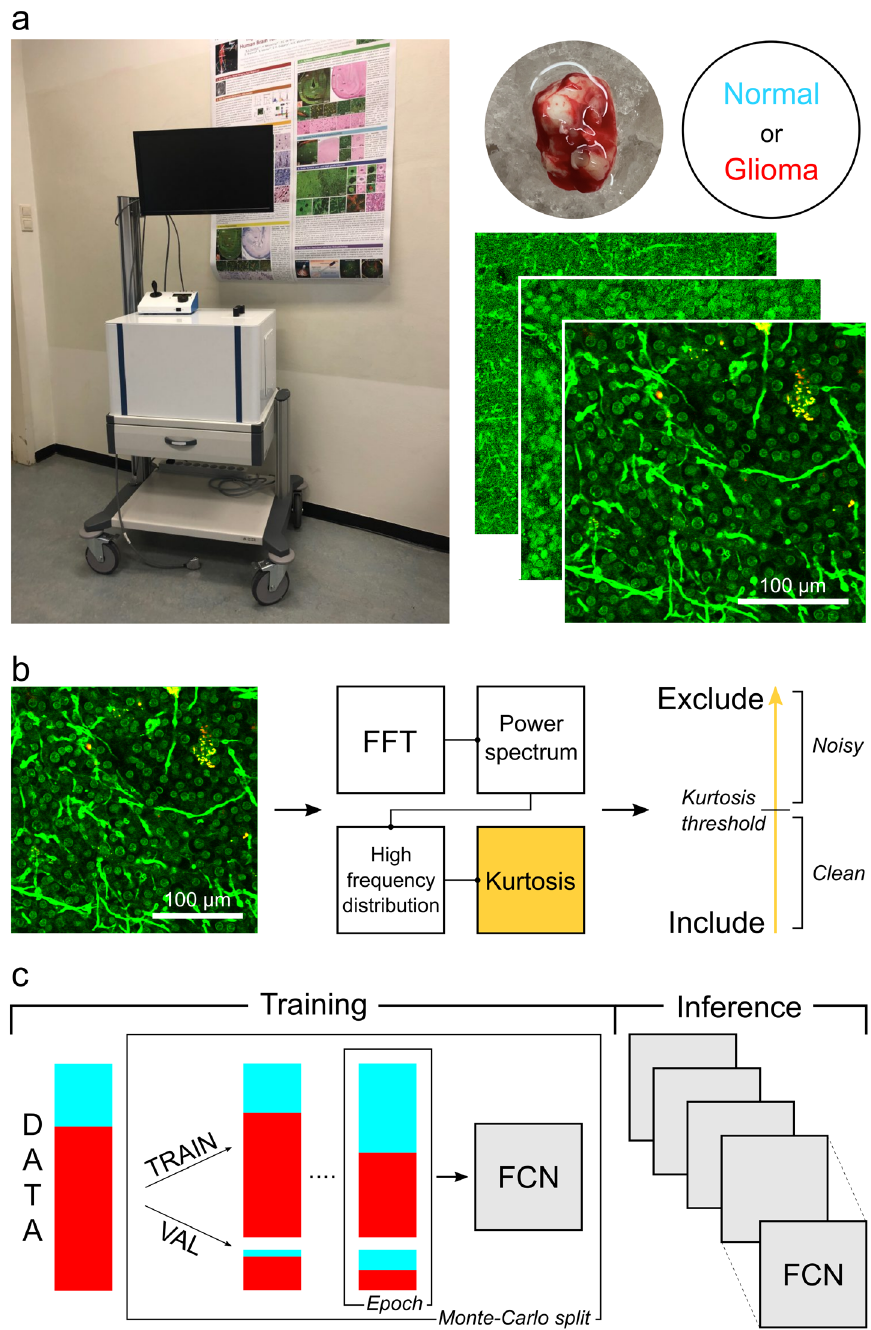
Figure 1. Complete tissue-to-inference pipeline with portable THG setup and deep learning. ( a ) Data acquisition using the portable THG setup (Flash Pathology B.V.). THG microscopy enables the acquisition of a ‘shadow contrast’ image, where myelinated fibers appear as bright curves and neuronal cell nuclei are dimly visible, while neuronal cell bodies appear as dark holes. Time to acquire image is approximately 3.5 s. ( b ) Data denoising by computation of descriptive statistics. Each image in the training set is processed to obtain the high frequencies distribution of the image’s frequency domain. Depending on the frequency distribution kurtosis, the image is either included or excluded from the training set. ( c ) Deep learning model training and inference on THG data, using Monte-Carlo cross-validation. The result is a series of optimized fully-convolutional models that are used during inference. The models are evaluated on a hold-out testing